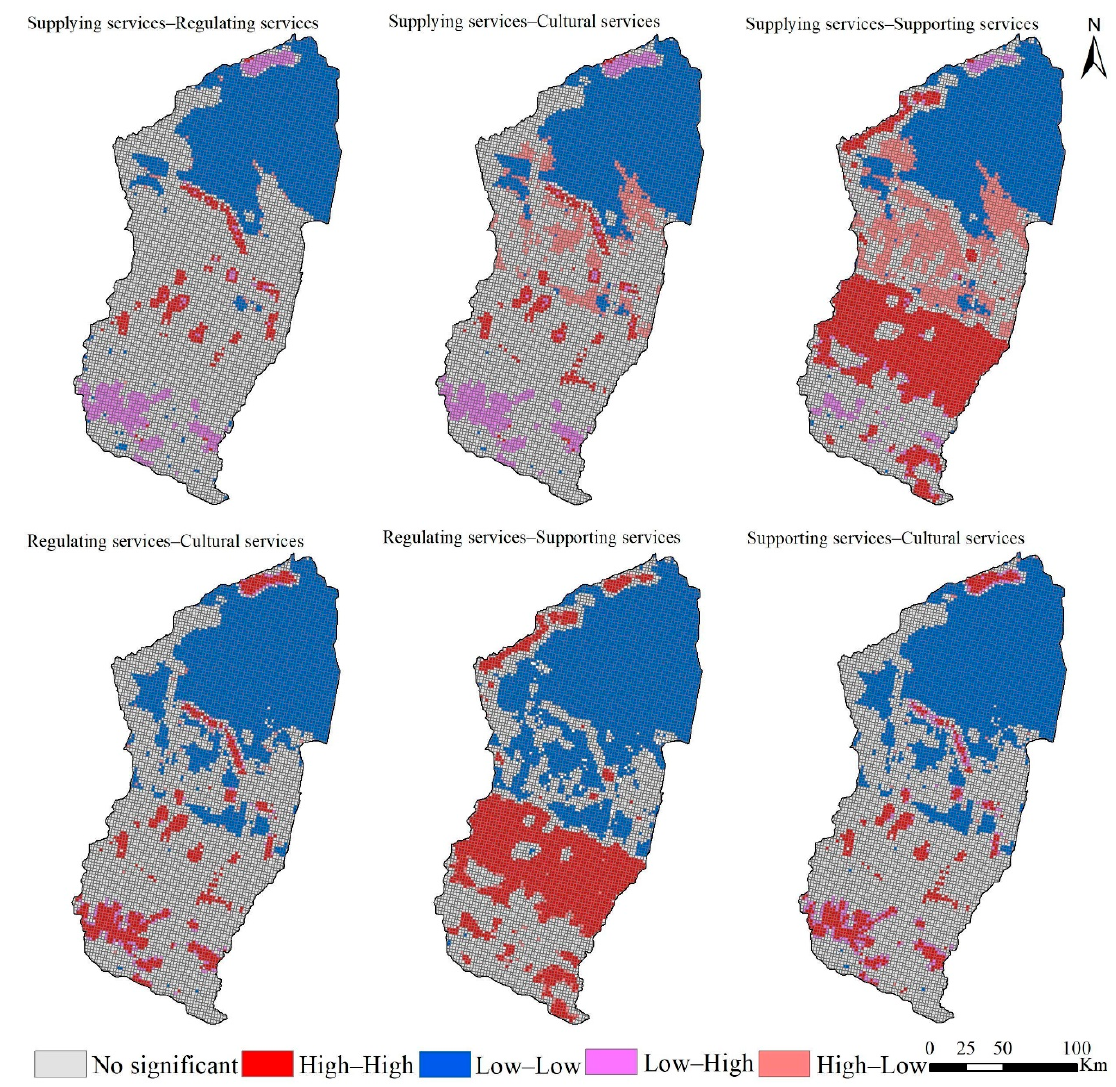
Figure 10. Partial LISA map showing the four ecosystem services in the Manas River Basin under the EED scenario in 2030.